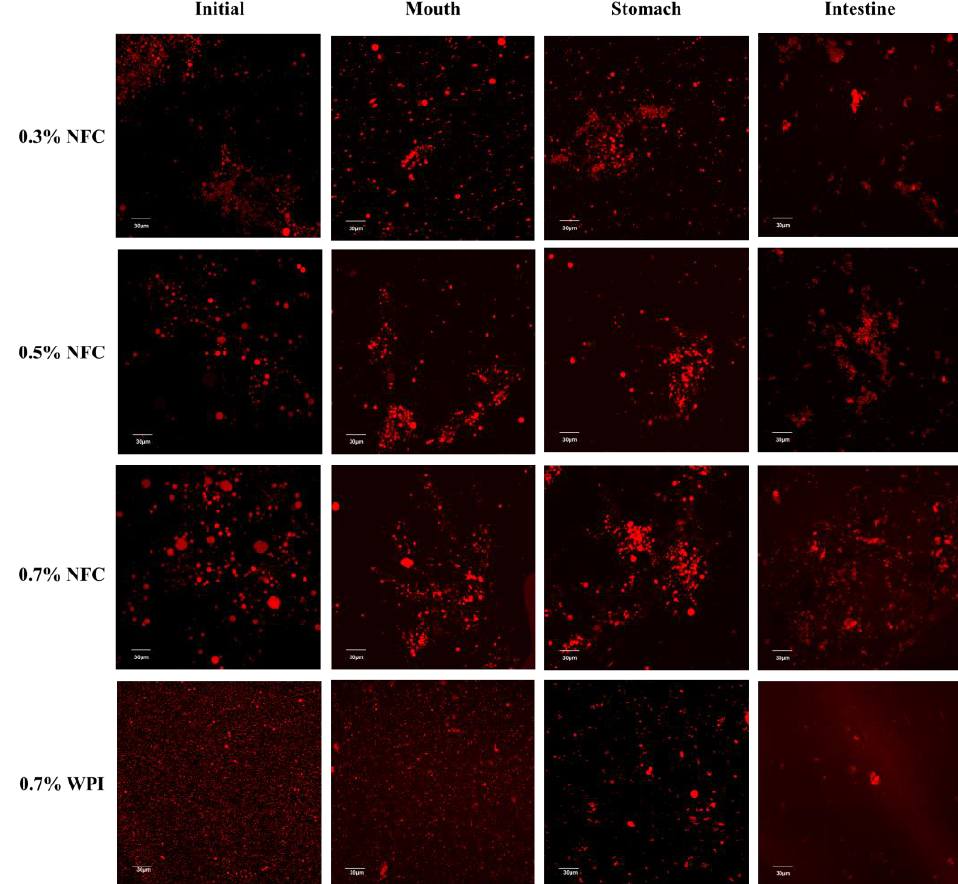
Figure 4. Confocal microscopy images of AX-loaded emulsions prepared with different emulsifier concentrations. The scale bar is 30 µm.